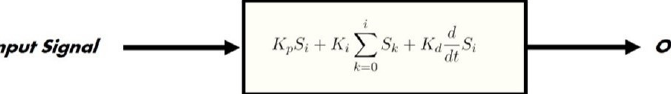
Figure 11. PID controller diagram.